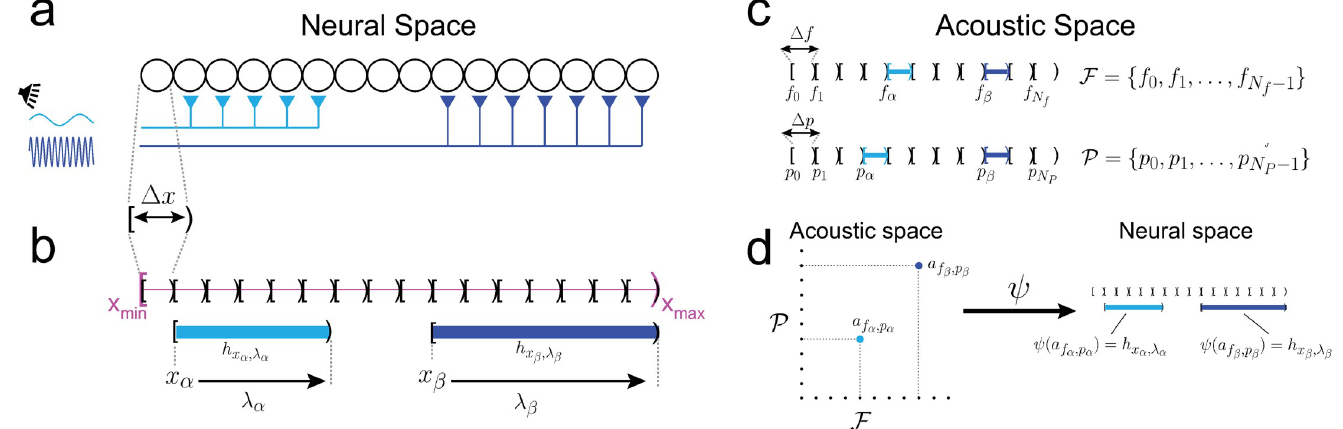
Fig 2. Mathematical representation of neural and acoustic spaces. a , neurons on the tonotopic axis are positioned next to each other with no space in between. Pure tone stimuli activate afferents onto a subset of neurons (cyan, blue). b , mathematical representation of neural space. The tonotopic axis is a half-open interval (magenta) partitioned into smaller intervals that represent the space ( Δ x ) taken up by neurons. The synaptic fields ( h acoustic space has two dimensions, with frequency as one axis and pressure as the other. The frequency and pressure spaces are partitioned into half-open intervals of length Δ f , Δ p , respectively. d , Mapping tones in the acoustic space to intervals in neural space via a function ψ .